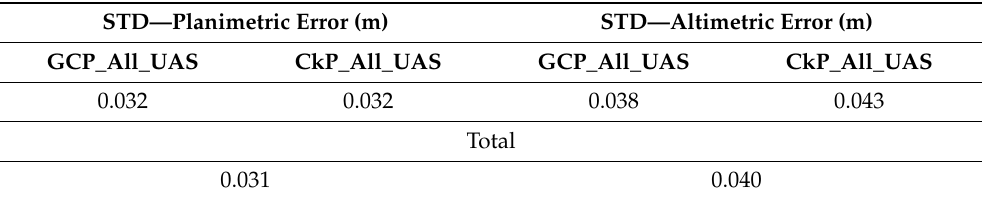
Figure 15. Chart of median calculated for the altimetric error. Figure 16. Chart of standard deviations calculated for the planimetric error.